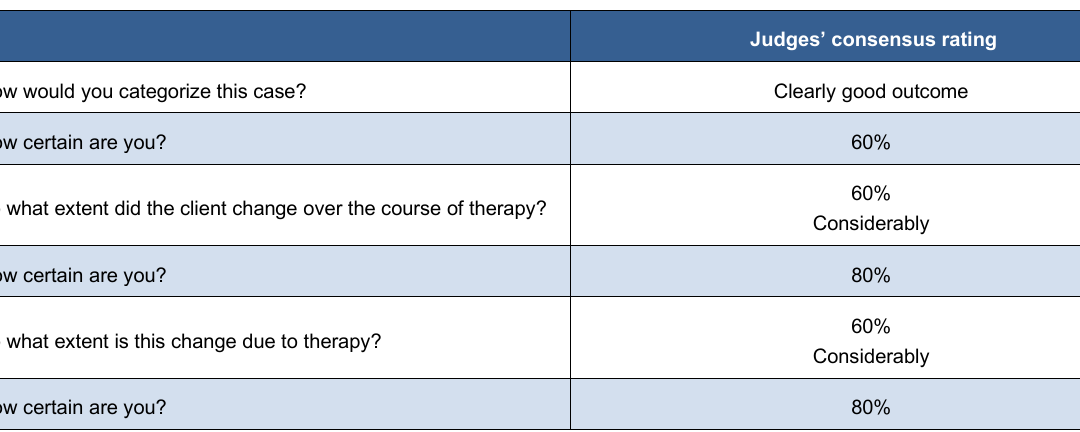
Table 5: Adjudication